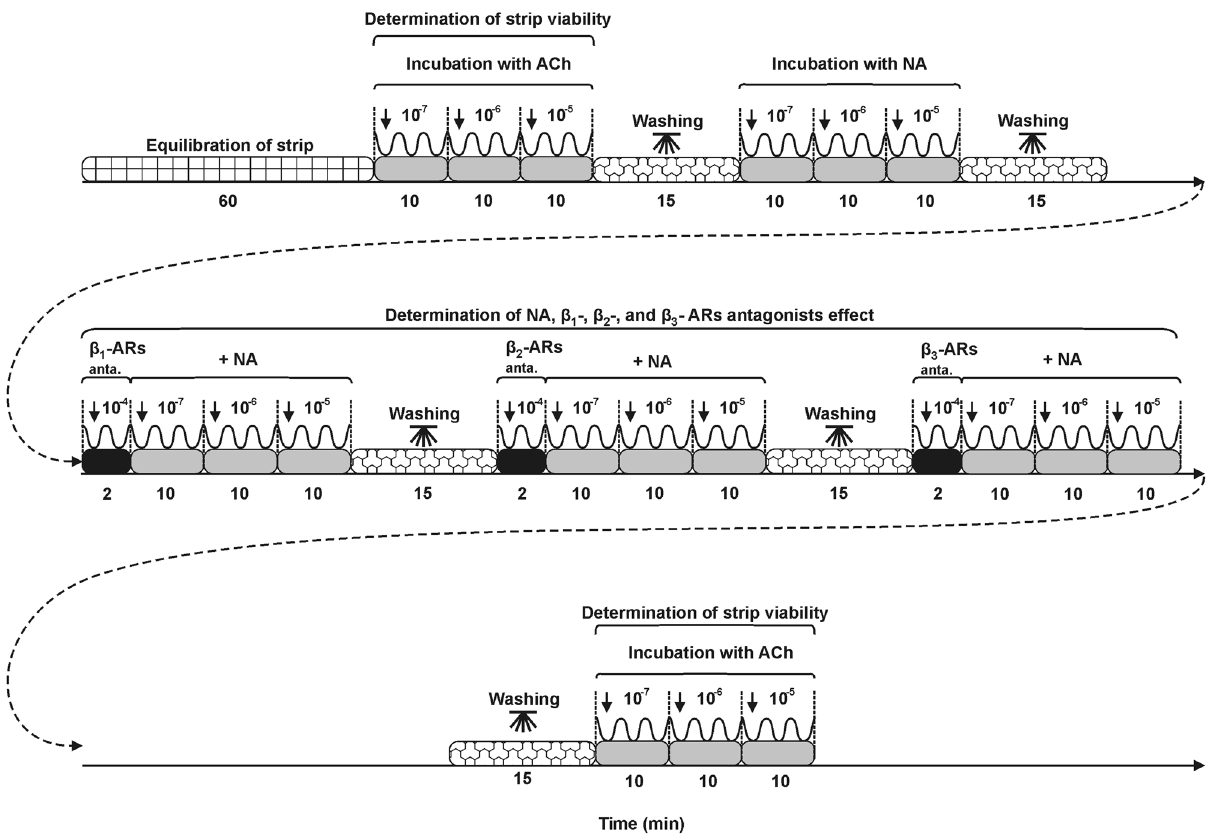
Figure 5. Diagram showing treatment of the uterine strips. Ach—acetylcholine; NA—noradrenaline; β1-ARs anta.—adrenergic β receptor subtype 1 antagonist; β2-ARs anta.—adrenergic β receptor subtype 2 antagonist; β3-ARs anta.—adrenergic β receptor subtype 3 antagonist. Concentrations of the used substances are given in